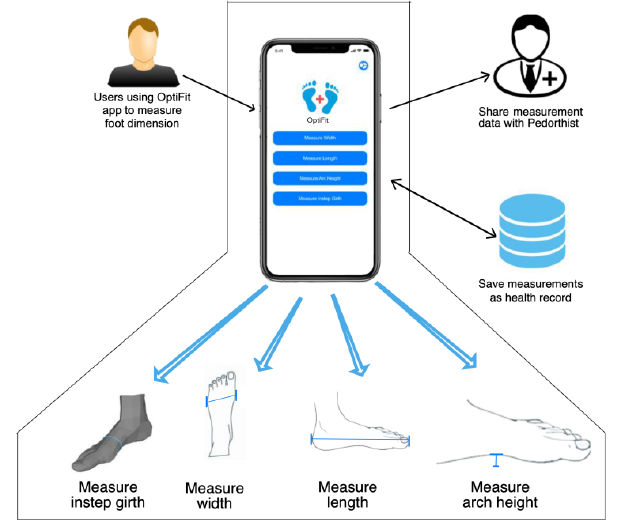
Figure 3. Application